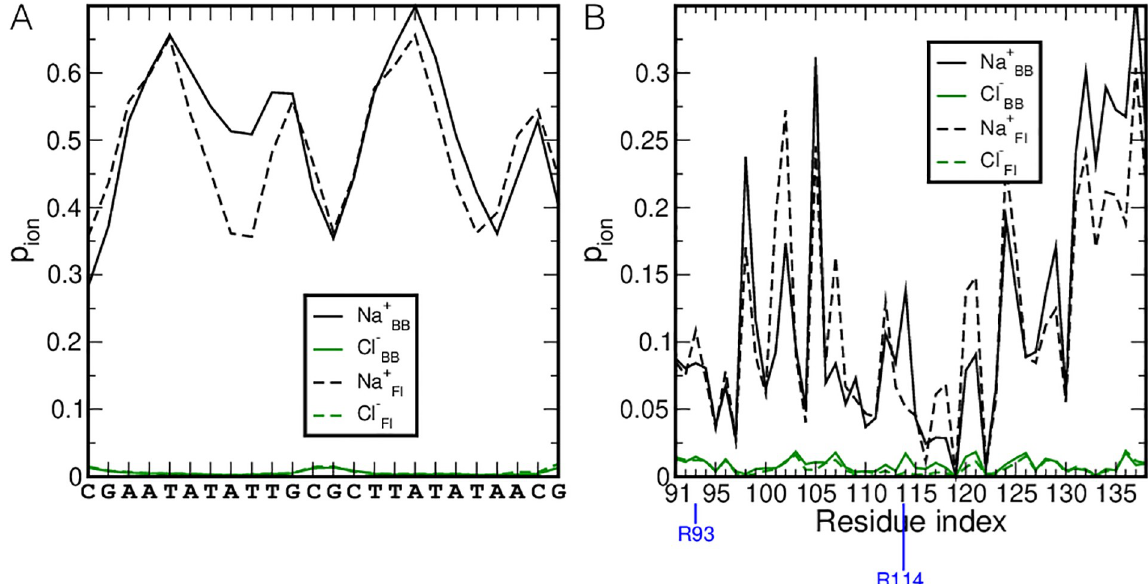
Fig 5. Proximity of ions during binding. The probability of finding Na + (black lines) and Cl − (green lines) within a minimum distance of 0.6 nm of (A) the DNA and (B) the protein is plotted as a function of (A) the nucleotide sequence or (B) the amino acid sequence. The dotted and solid lines indicate the probabilities for the BB and the FI states respectively. Residues R93 and R114 are marked with a blue line.